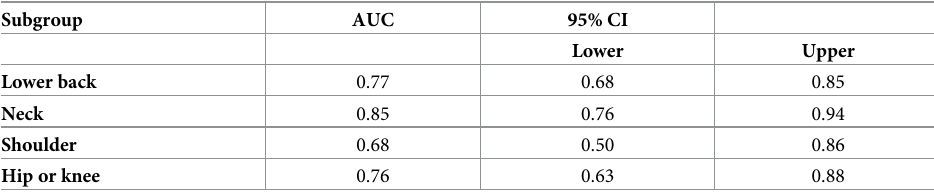
Table 4. Areas under the curve (AUC) by subgroup at initial assessment.